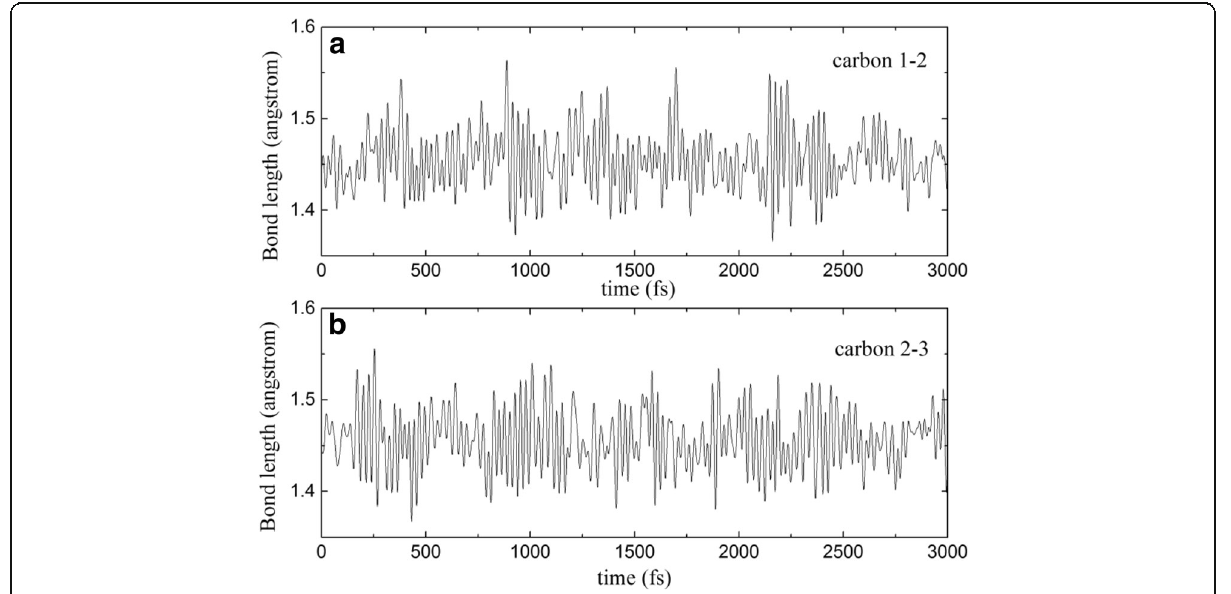
Fig. 2 The variation of bond length in molecular dynamic simulation at 300 K. a The bond between carbon 1 and 2. b The bond between carbon 2 and 3. The carbon 1, 2, and 3 are marked with red color in Fig. 1